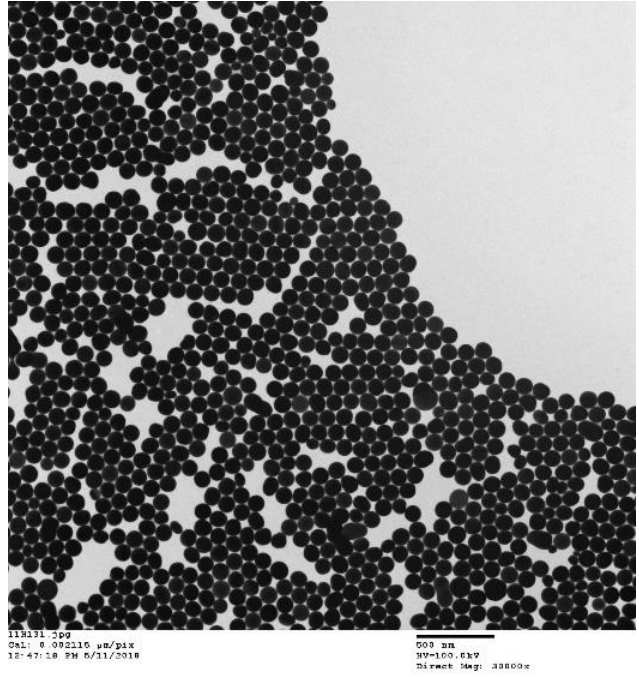
Figure 8. A TEM image of spherical gold nanoparticles (AuNPs), provided by Nanopartz Inc